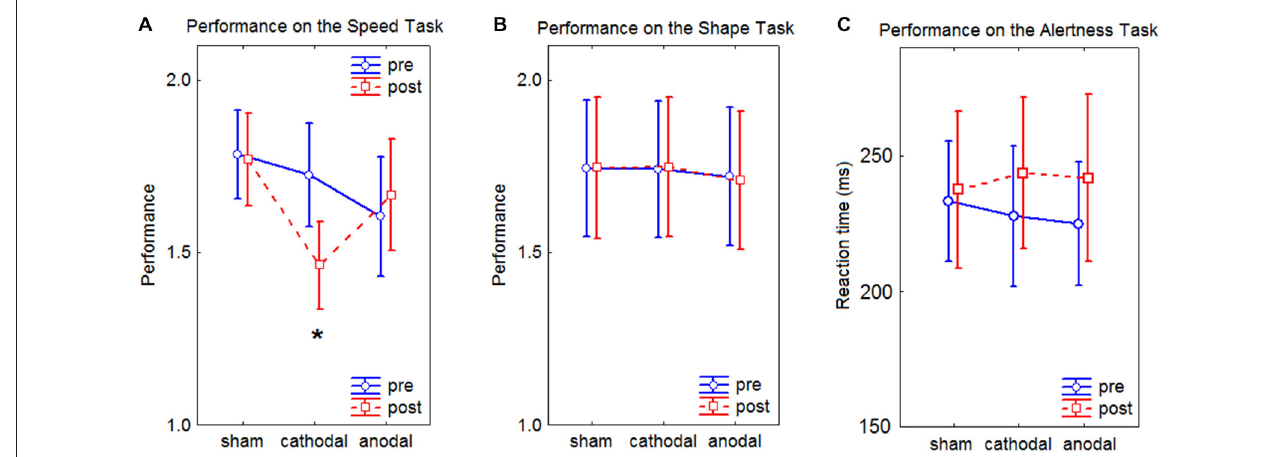
FIGURE 5 | Line charts of the results of the Speed Task, the Shape Task, and the Alertness Task. In the graphs, the performance represents the ratio between the two compared images. Values close to 1 depict high performance. Error bars represent the standard error of the mean. (A) results of the Speed Task, the asterisks depicts a significant difference at p < 0.05 as assessed by Tukey’s HSD post hoc tests. (B) results of the Shape Task. (C) results of the Alertness